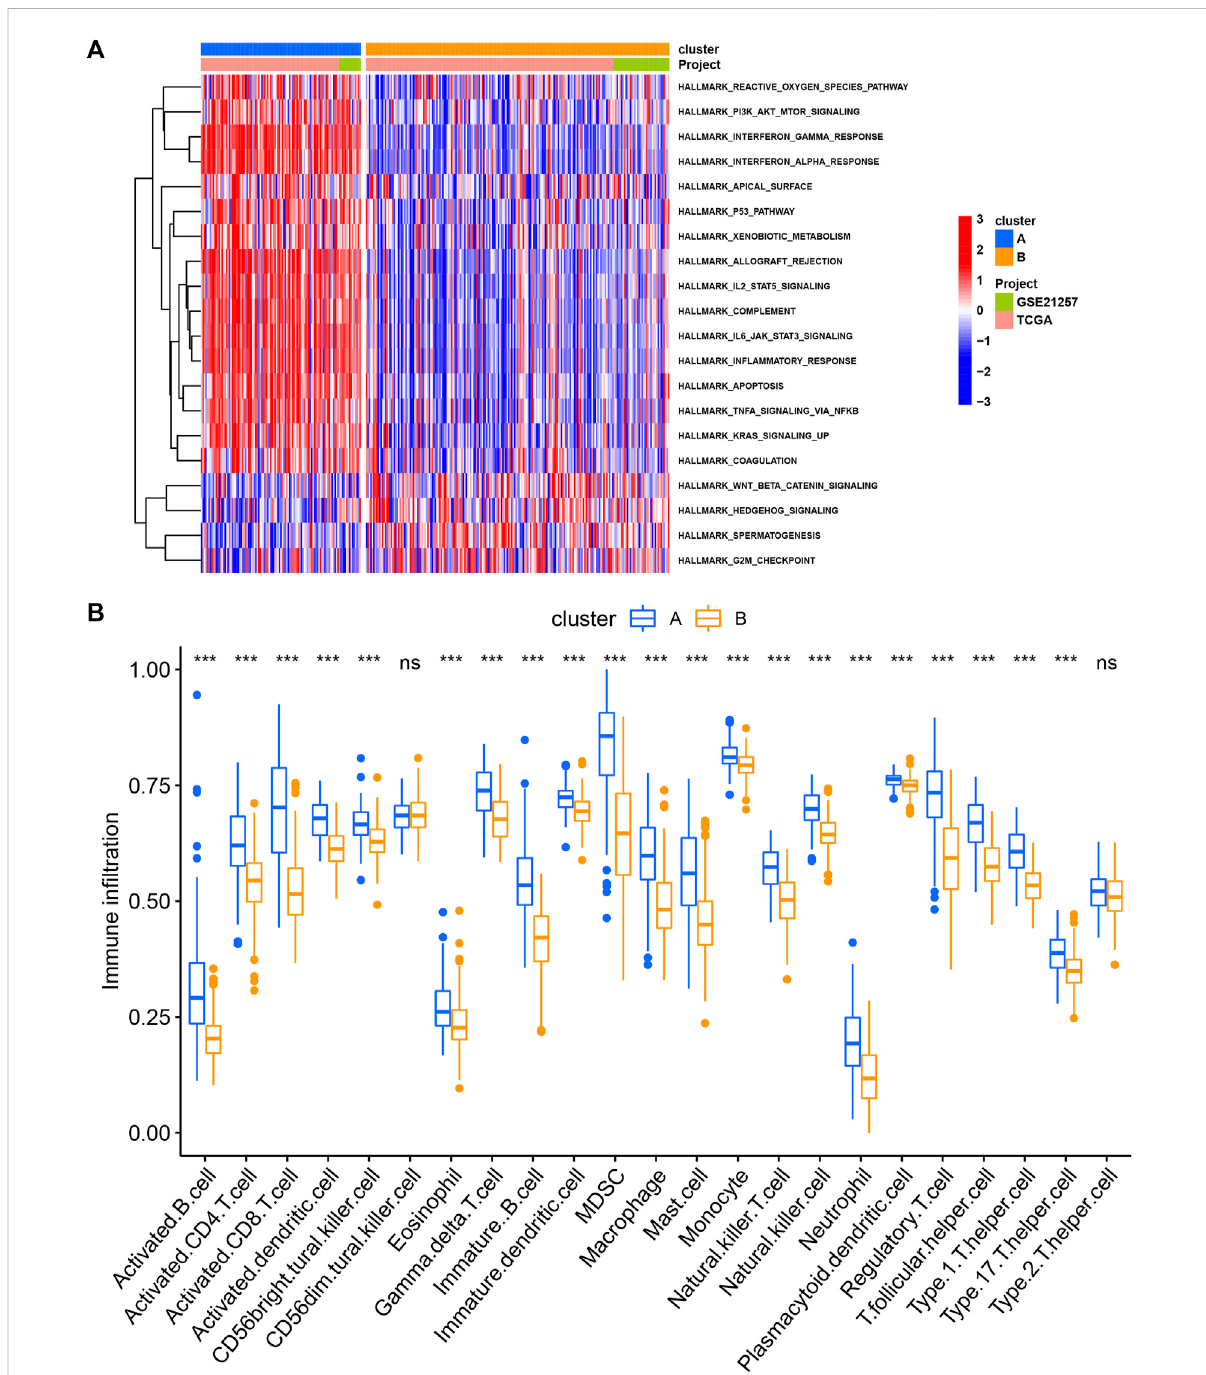
FIGURE 4 The different pathways (A) and immune in fi ltration (B) between cluster (A) and cluster (B) * p < 0.05, ** p < 0.01, *** p < 0.001, **** p <